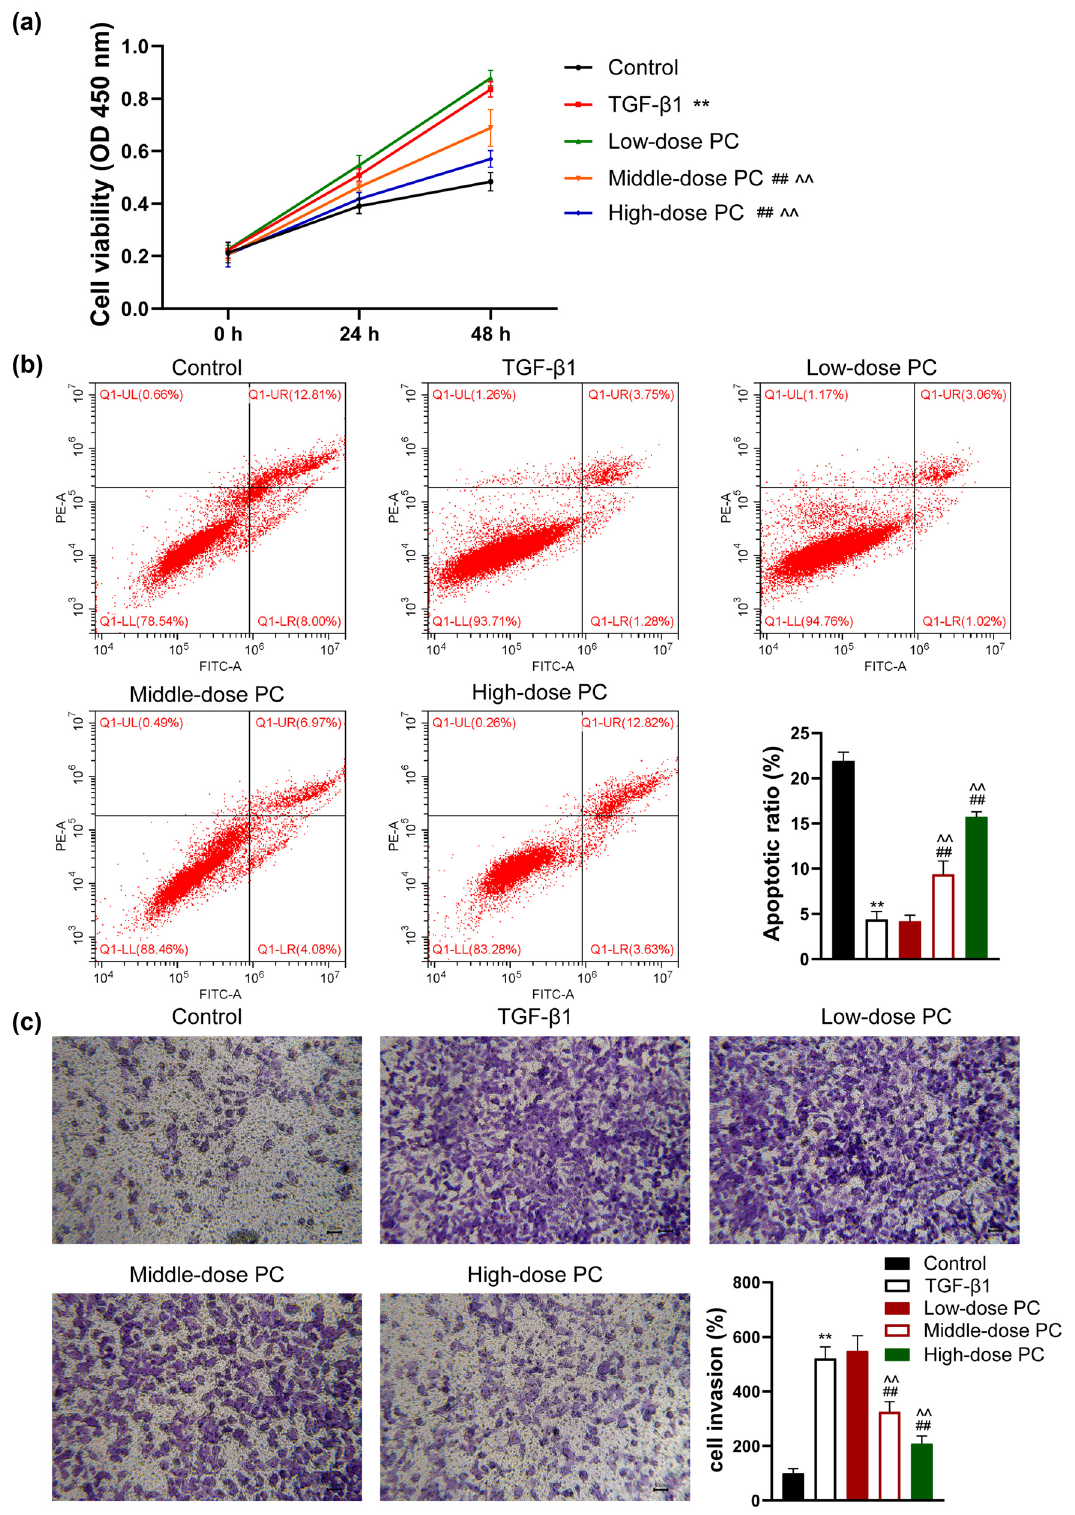
Figure 3: PC suppresses malignant progresses of HFL - 1 cells. ( a ) The proliferation of HFL - 1 cells was detected by CCK - 8 assay. ( b ) Cells ’ apoptosis was determined by fl ow cytometry assay. ( c ) The invasion of HFL - 1 cells was detected by Transwell assay ( scale bar = 50 μ m ) . HFL - 1 cells were stimulated by TGF - β 1 for 24 h and then cultured in the medium with di ff erent doses of prepared drug containing serum ( 5, 10, and 20% ) . ** P < 0.01 vs control, ## P < 0.01 vs TGF - β 1, ^^ P < 0.01 vs low - dose P